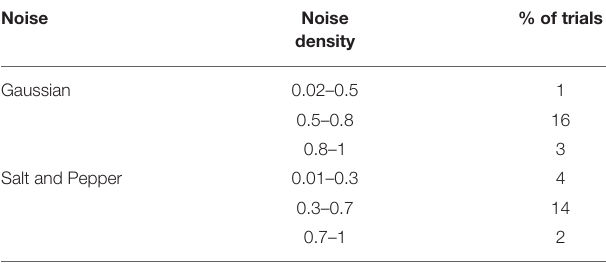
TABLE 2 | Network robustness statistics across 20